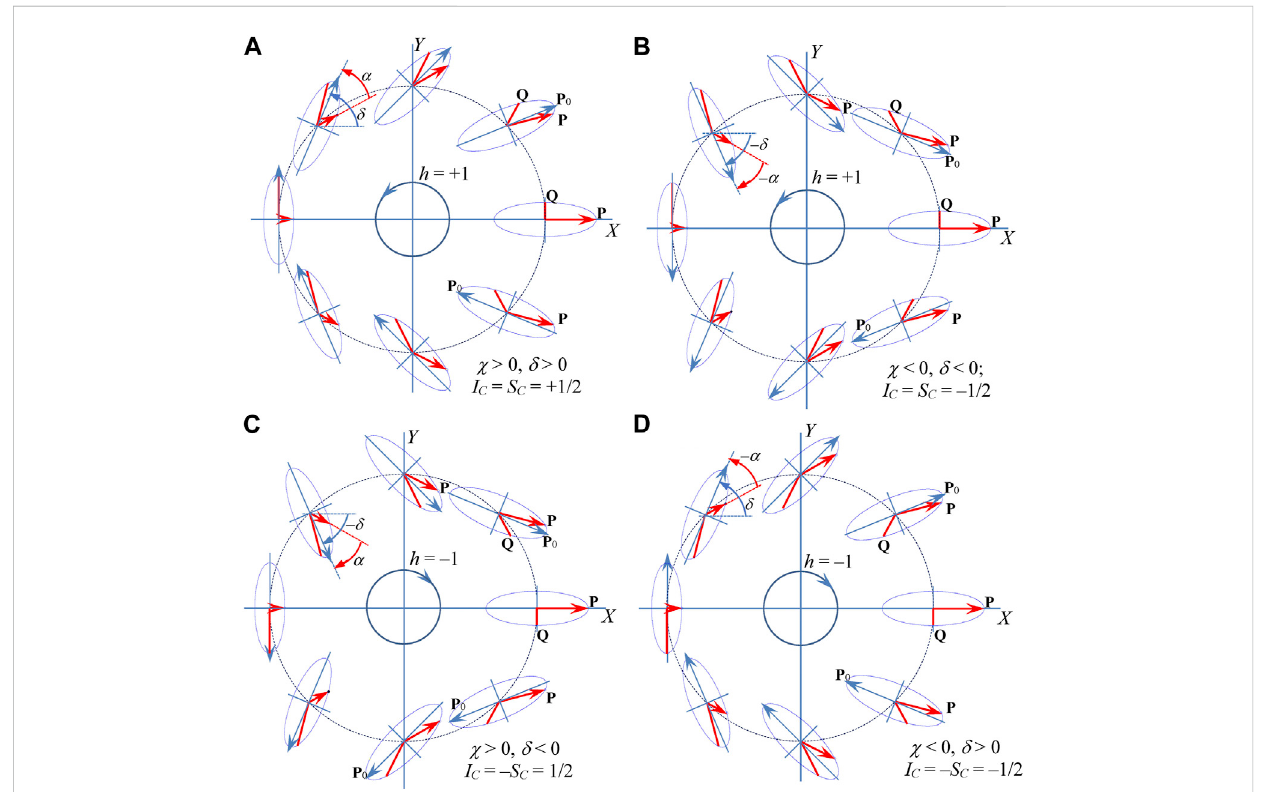
FIGURE 4 Polarization structure of the fi eld near a C -point depending on the polarization handedness (central circle with an arrow) and on the TC l of the singular component: (A) rightpolarization, u + ( r ) ≠ 0, u – ( r )~ x + iy ( l =+1); (B) rightpolarization, u + ( r ) ≠ 0, u – ( r )~ x — iy ( l = − 1); (C) leftpolarization, u – ( r ) ≠ 0, u x + iy ( l = +1); (D) left polarization, u – ( r ) ≠ 0, u x — iy ( l = − 1). Upper left ellipses of each panel illustrate the geometric de fi nitions of the + ( r ) ~ + ( r ) ~ polarization azimuth δ and the angle α corresponding to the main phase χ Eq. 2.15; further explanations see in